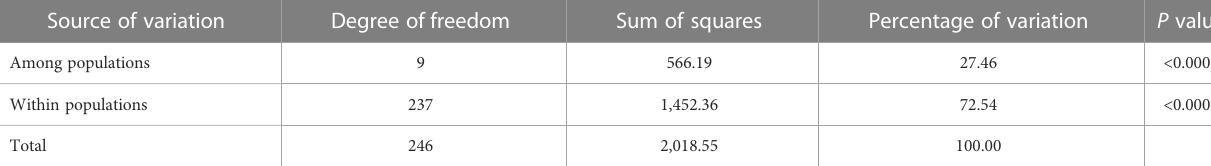
TABLE 5 Analysis of molecular variance (AMOVA) among and within